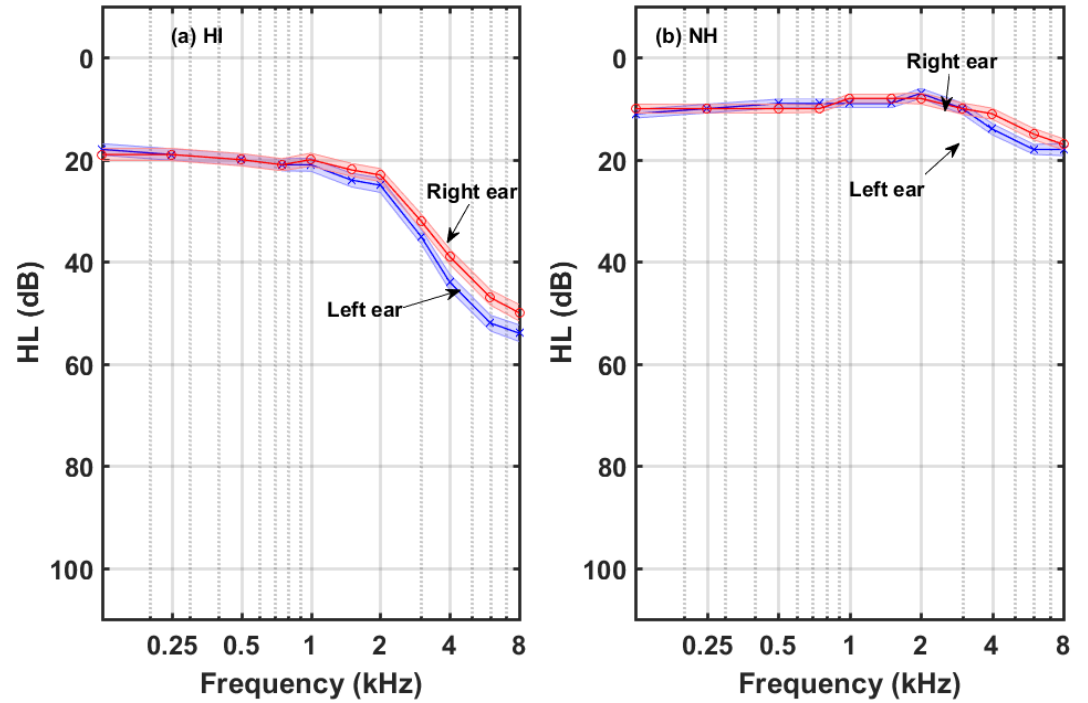
Figure 3. Mean hearing levels of the ( a ) 201 HI and ( b ) 69 NH participants in left and right ears. Shaded area around the HL curves outlines confidence intervals.